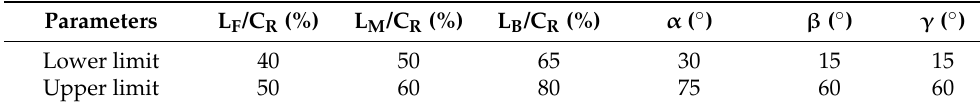
Table 3. Tested values of six geometric parameters.